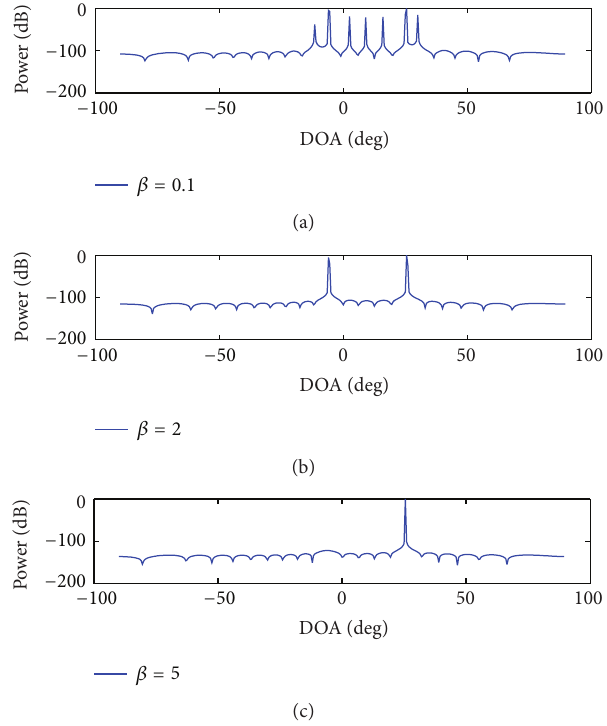
Figure 1: Spatial spectra of NR-SpCF for different 𝛽